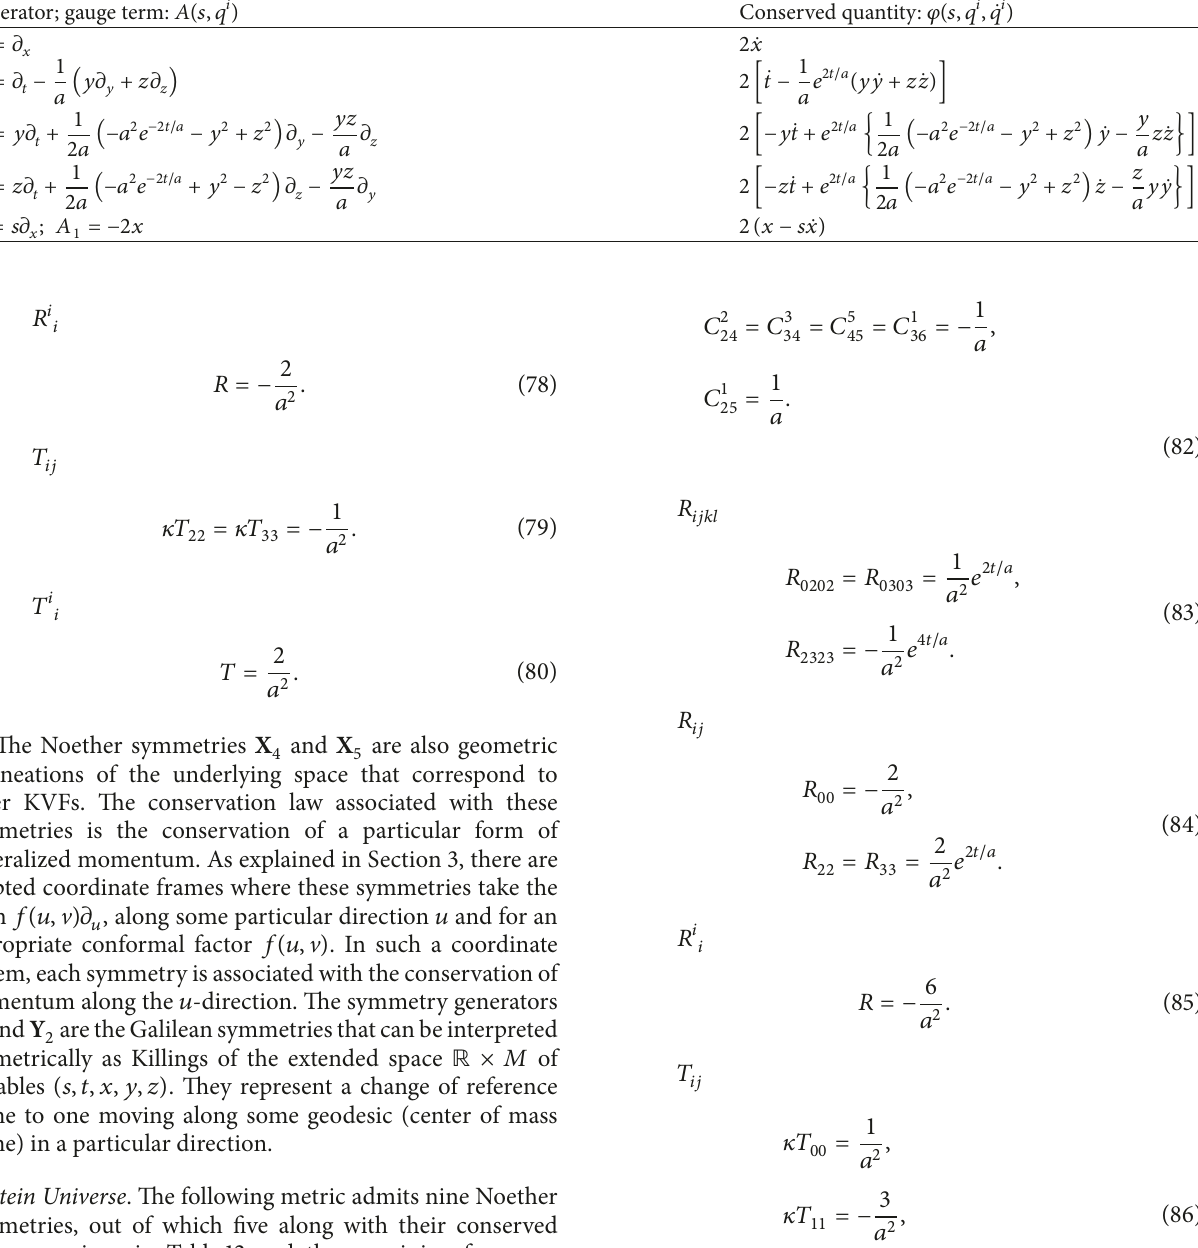
Table 12: Conserved quantities corresponding to each Noether